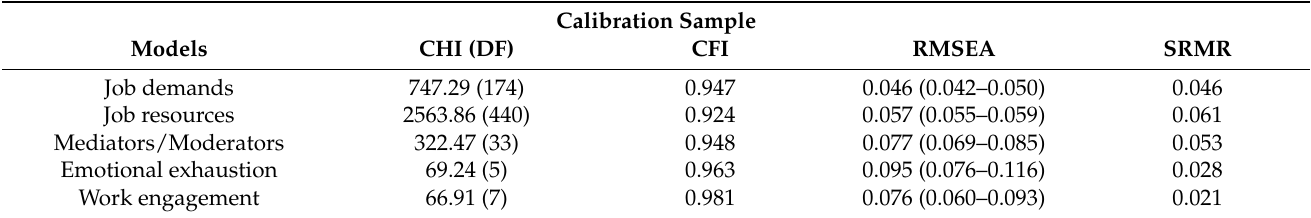
Table 2. Confirmatory factor analysis aggregated by demands, resources, mediators, and outcomes in calibration sample (N =